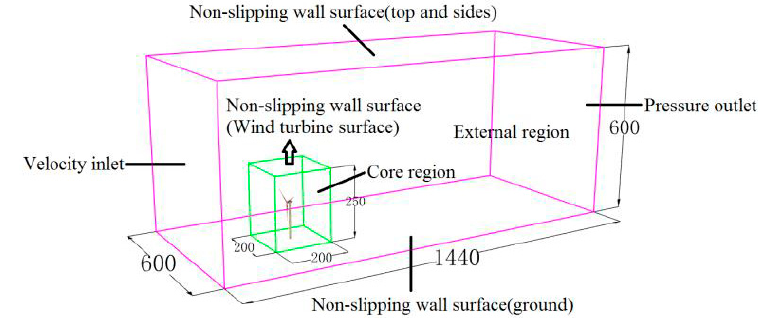
Figure 11. Boundary conditions of the computational domain (unit: m).